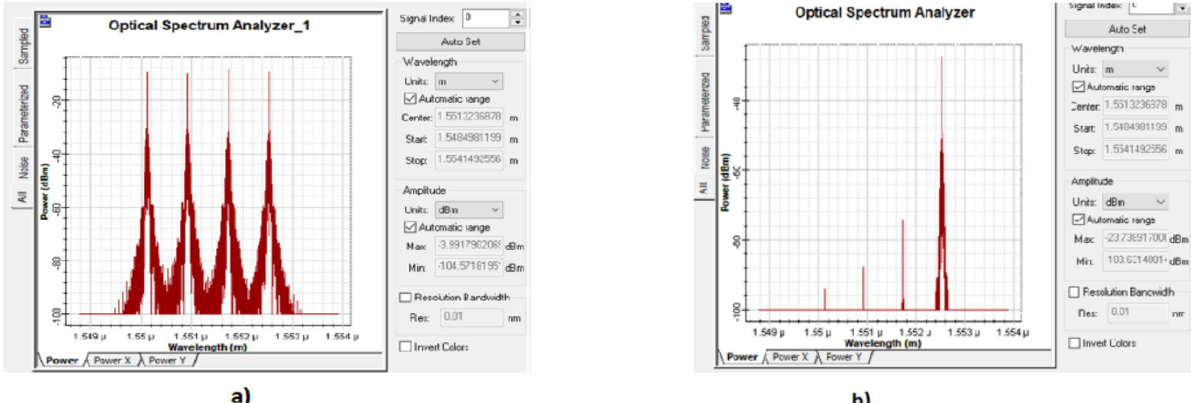
Figure 7. Result of WDM analysis with 4 channels spectrum appearance a) on transmitting and b) receiving side filtered only one